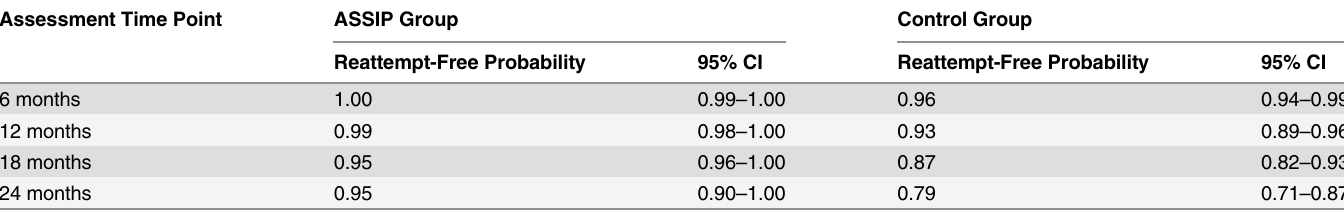
Table 3. Estimated reattempt-free survival probability during 24-month follow-up. Assessment Time